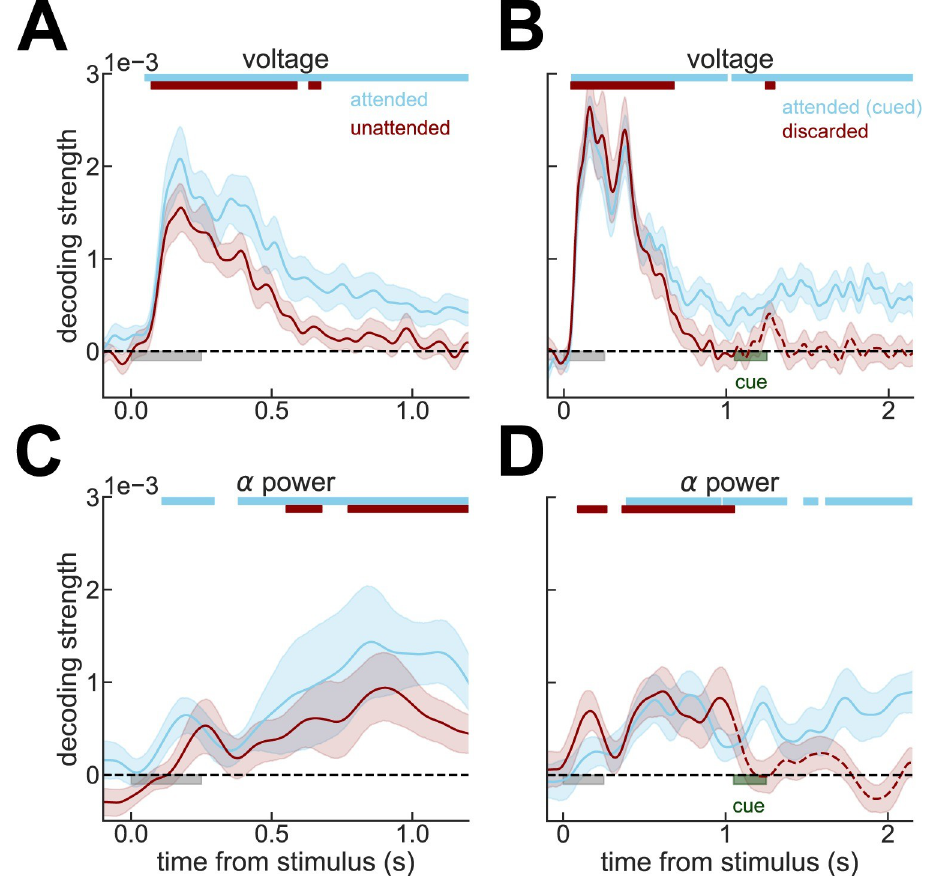
Fig 1. Decoding from alpha power reveals an underlying, active working memory code. (A) Strength of stimulus decoding from raw voltage traces as in [7]. As in the original study, unattended or ( B) discarded memories cannot be decoded from raw voltage traces. (C, D) Same as (A) and (B), but decoding from alpha power (Methods), which reveals a sustained representation of the unattended stimulus. In (A) and (C), we analyze data from experiment 2 [7], while in (B) and (D), data from experiment 1 [7]. Light gray bars mark stimulus presentation periods. Notice that data immediately preceding pinging stimulus presentation are shown in this figure. Dashed lines mark the periods in which memories are irrelevant for upcoming behavior, following an instruction cue (dark green). All error bars are bootstrapped SEM, and color bars on the top mark the periods where bootstrapped 95% CI was above zero. Data from Wolff and colleagues (2017)